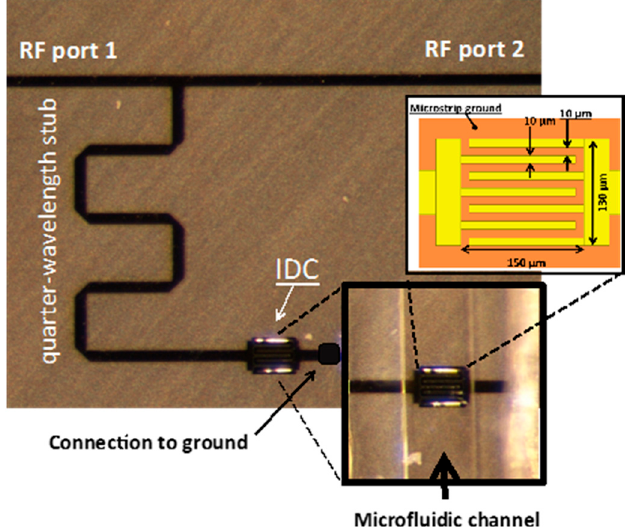
Figure 1. Fabricated biosensor consisting of a quarter wave-length stub implemented in a thin film microstrip technology. Inlets provide the detailed architecture of the inter-digitated capacitor (IDC) equipped with the microfluidic channel and the IDC dimensions.